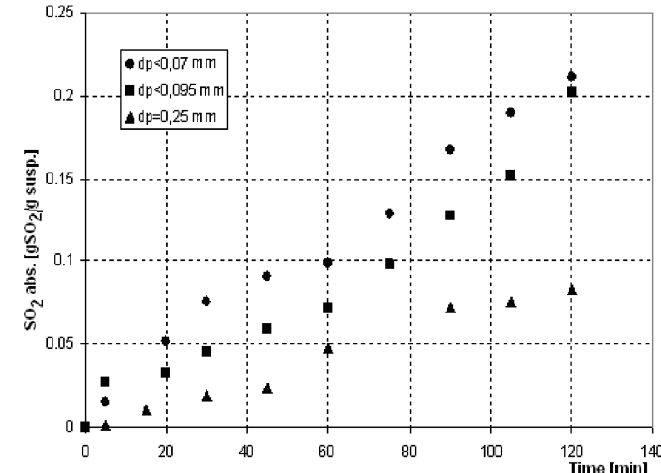
Figure 5. Kinetic data in sulfur dioxide absorption in CCP slurry with S/L=1/20 and T=298 K.